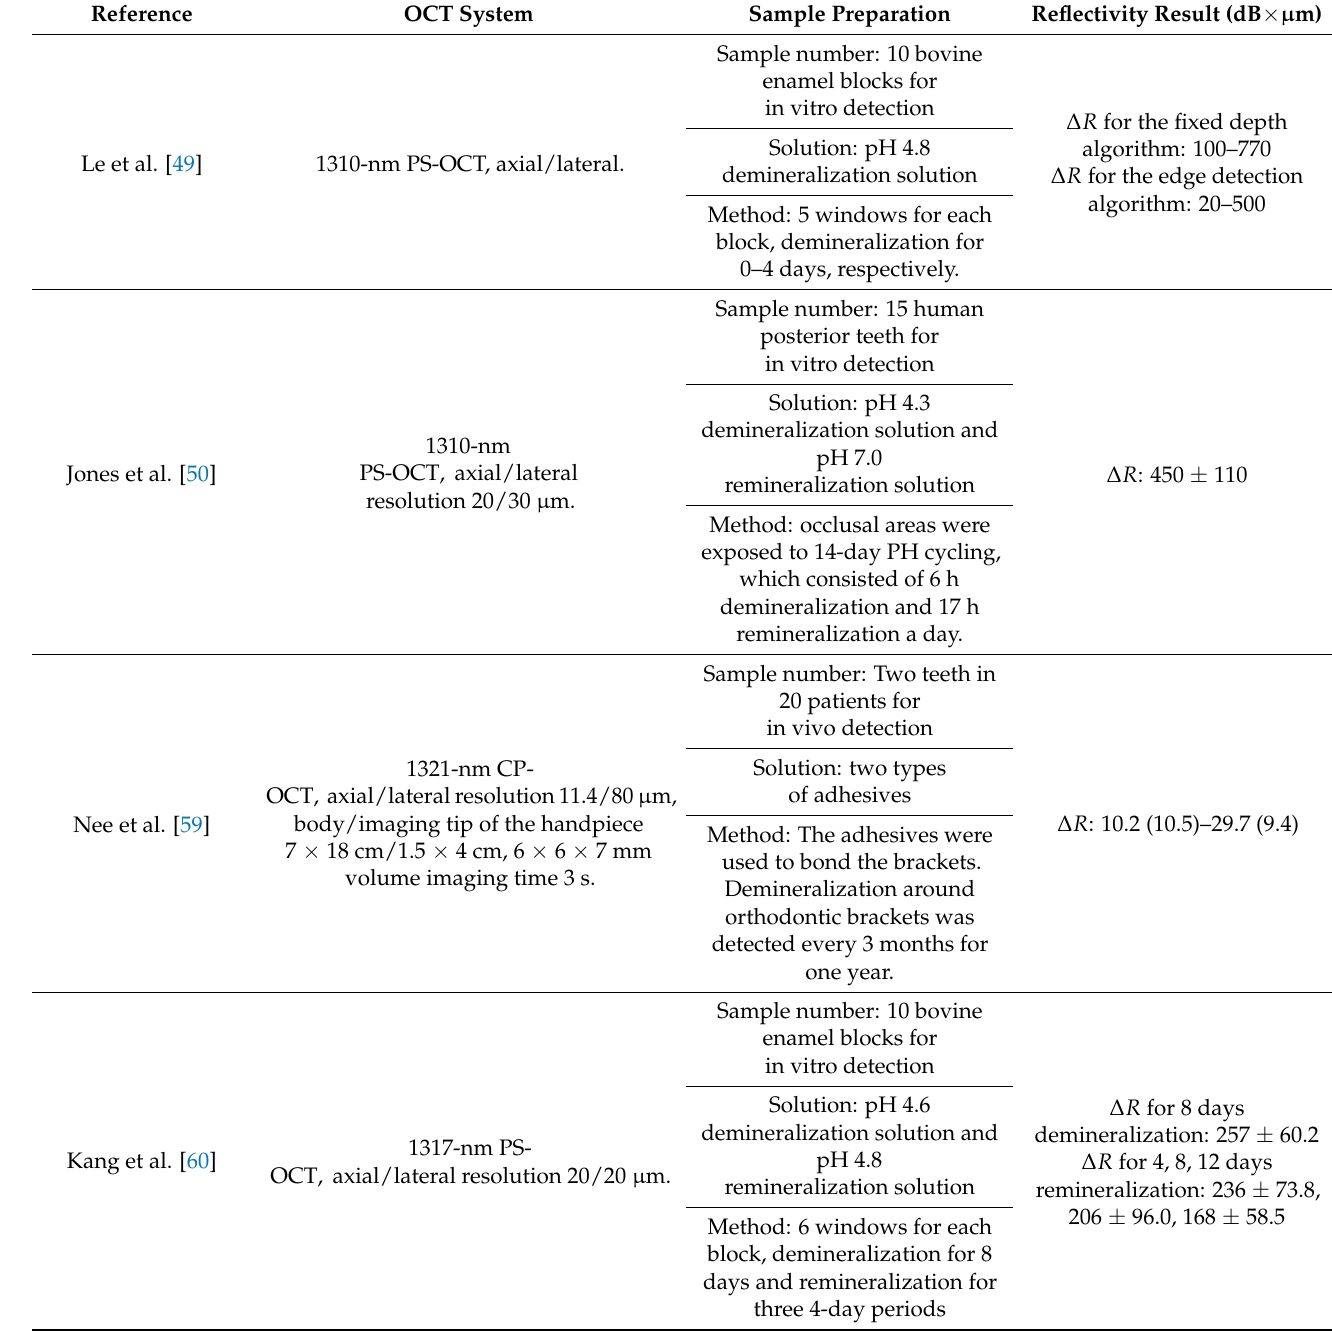
Table 2. Results of quantifyin0p-[g enamel caries with